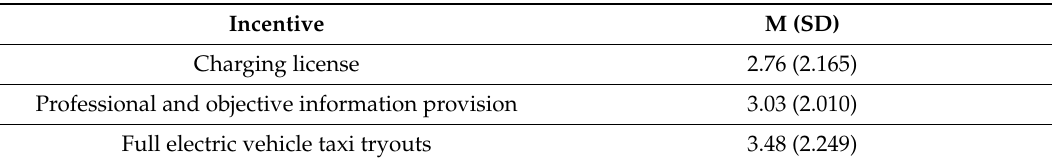
Table 1. Attractiveness ratings of the